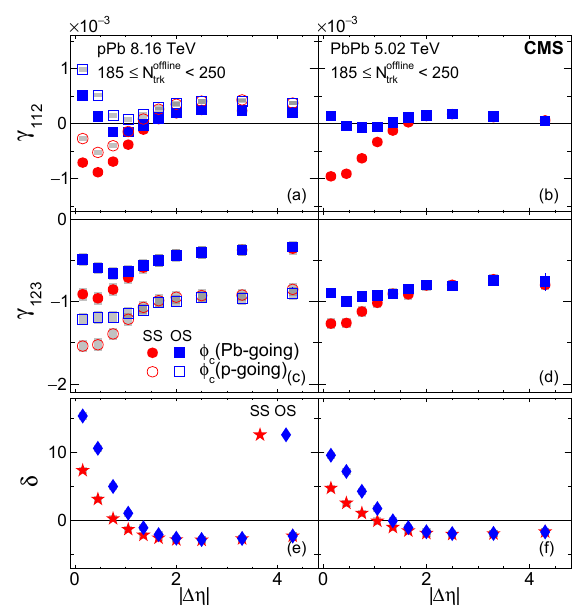
Figure 1. The same sign (SS) and opposite sign (OS) three-particle correlators, γ 112 (upper) and γ 123 (middle), and two-particle correlator, δ (lower), as a function of 8 . 16 TeV (left) and PbPb collisions at 5.02 TeV (right) [14]. The pPb results obtained with particle c in Pb-going (solid markers) and p-going (open markers) sides are shown separately. The SS and OS two-particle correlators are denoted by di ff erent markers for both pPb and PbPb collisions. Statistical and systematic uncertainties are indicated by the error bars and shaded regions,